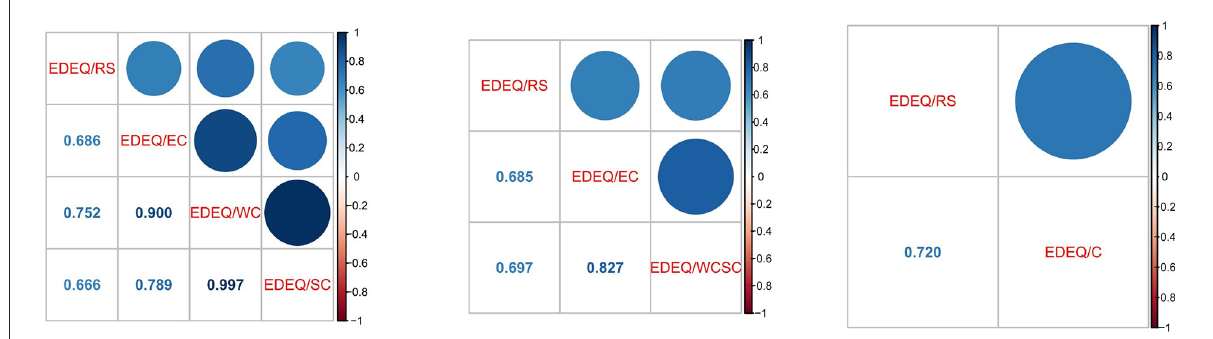
Table 3, the standardized factor loadings ranged from λ ∗ = 0.549 (item 3) to λ ∗ = 0.777 (item 11). Overall, fit was quite poor (NC = 7.026; robust CFI = 0.942, robust RMSEA = 0.084).